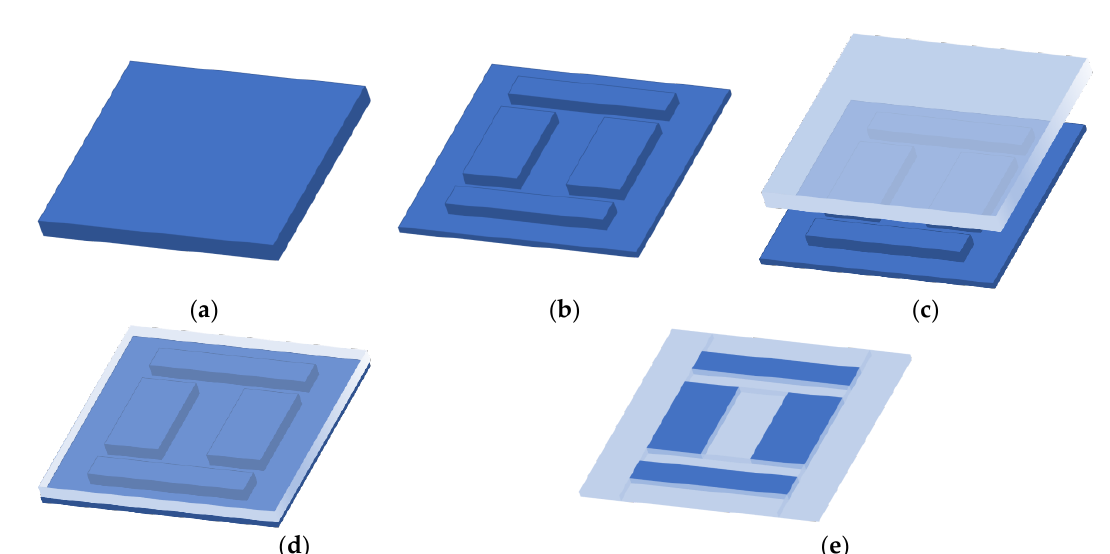
Figure 3. The fabrication process of silicon–glass composite wafers. ( a ) Si wafer, ( b ) deep reactive ion etching (DRIE), ( c ) anodic bonding, ( d ) filling melted borosilicate glass, ( e ) chemical mechanical polishing (CMP).